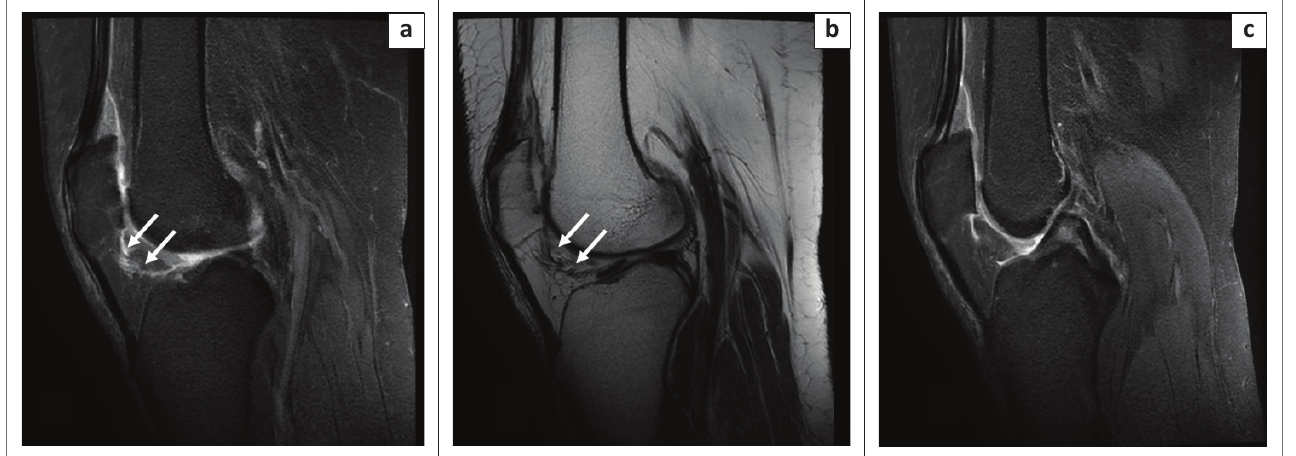
FIG URE 6: Magnetic resonance imaging of an infrapatellar plica tear in a 53-year-old female with a history of anterior knee pain: oblique sagittal PDFS image (a) and T2WI (b) reveal a hyperintense fluid collection along the entire course of the infrapatellar plica (arrows), with ragged margins. Oblique sagittal PDFS image (c) indicates a normal anterior cruciate ligament and posterior cruciate ligament in the patient.